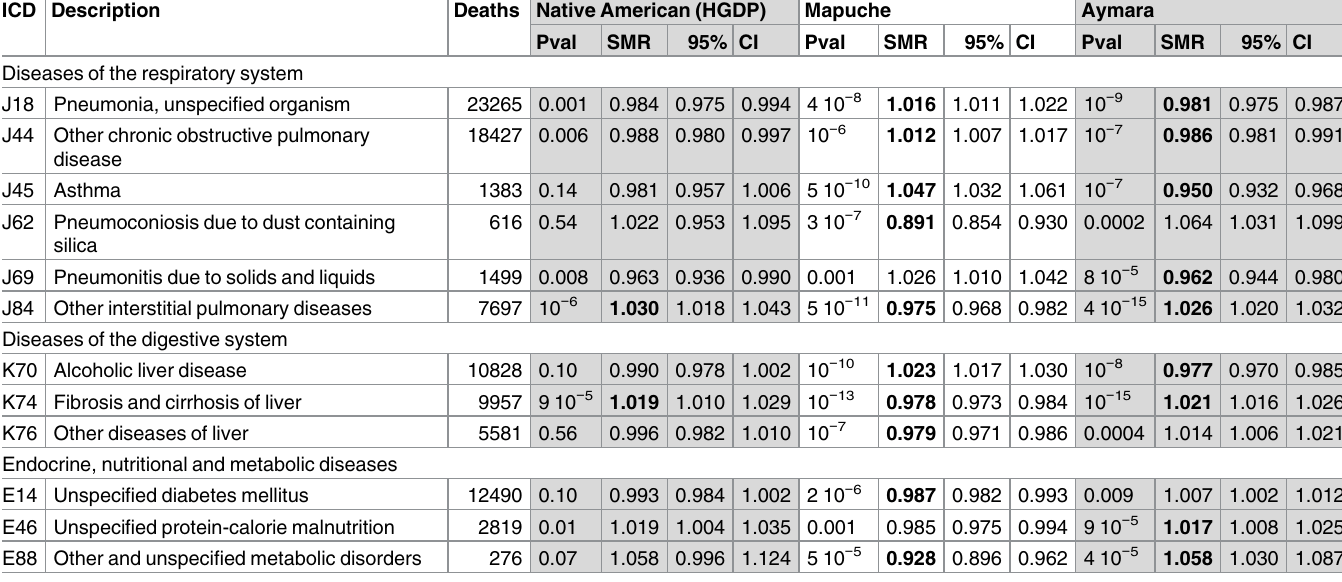
Table 3. Total number of deaths and standardized mortality ratios (SMR) due to respiratory, digestive and endocrine diseases by 1% increasein the Native American (HGDP), Mapuche and Aymaraproportions.